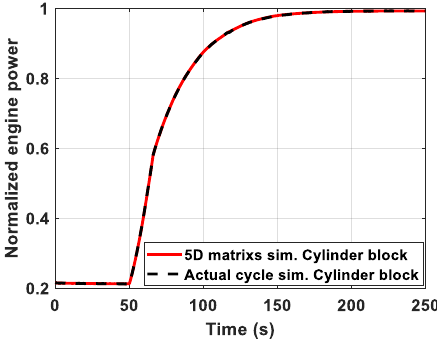
Figure 8. Engine power time history.